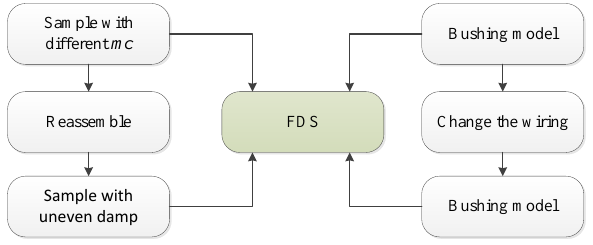
Figure 3. Experimental procedure and sample preparation.